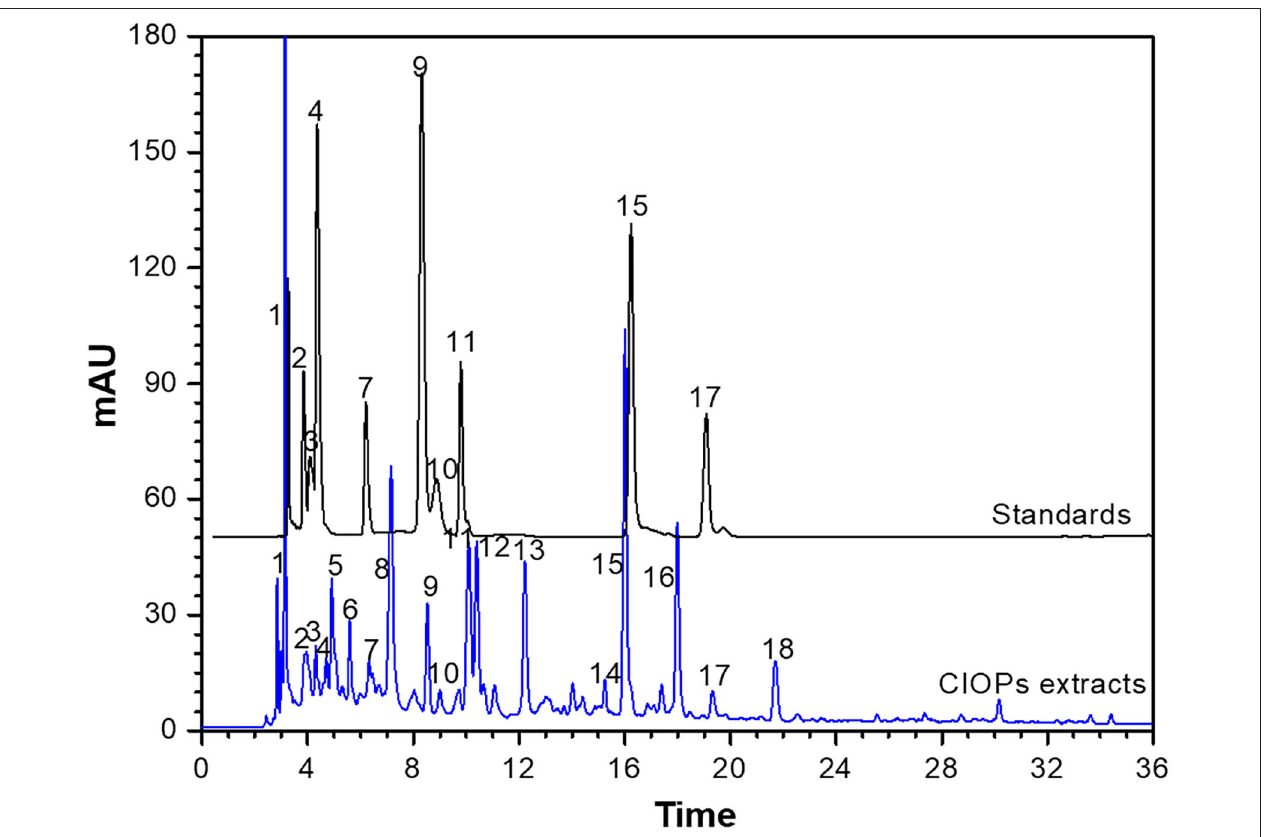
FIGURE 2 | High-performance liquid chromatography (HPLC) profiles of the phenolic compounds of the CIOPs extracts and the